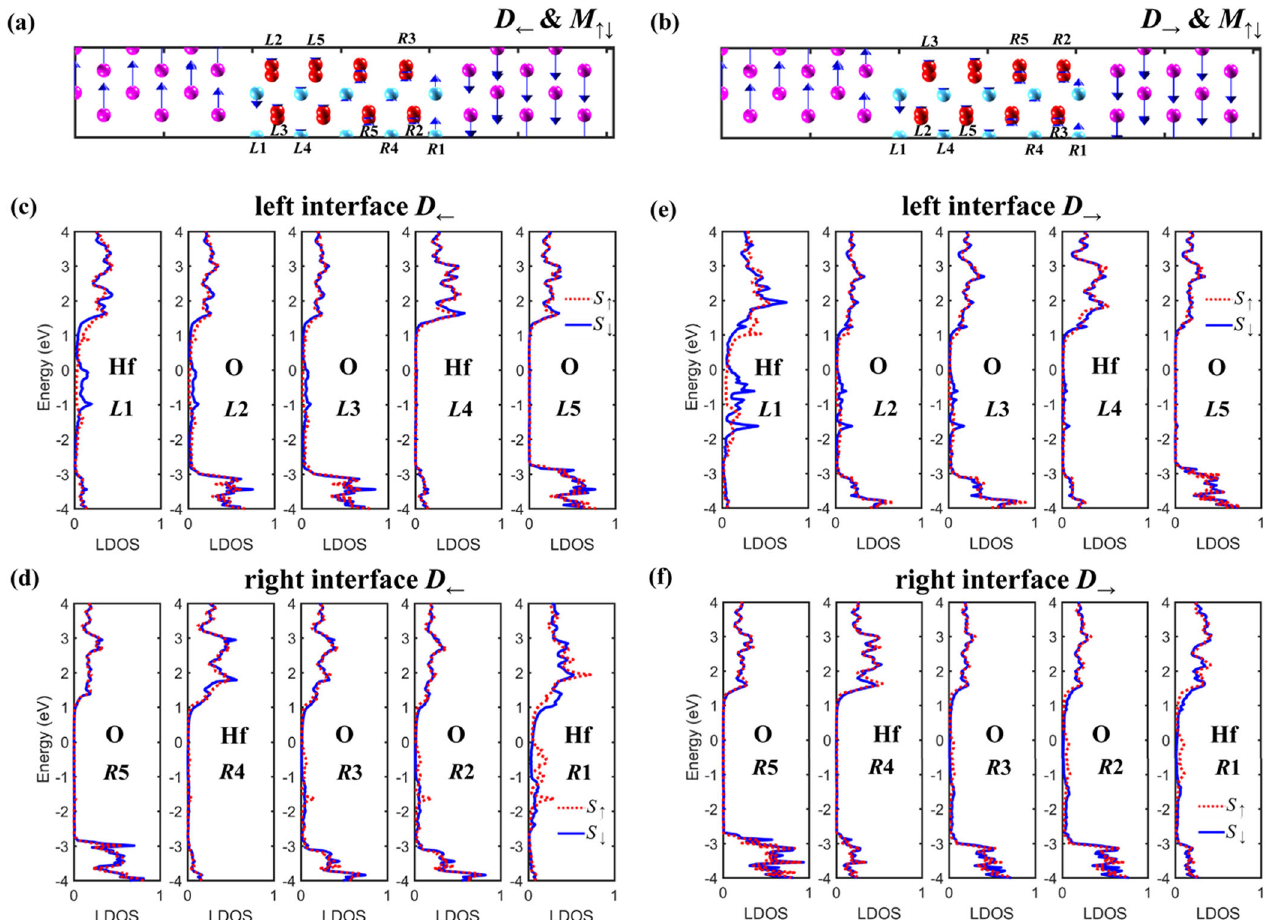
Fig. 4 Local magnetic moments and local density of states of Co/HfO 2 /Co junctions with Hf-terminated interfaces. Local magnetic moments of Co/HfO 2 /Co junctions with Hf-terminated interfaces at an antiparallel state: ( a ) D ← and ( b ) D → . The fi ve atomistic layers at the left and right interfaces are indicated. Layer dependent spin density of states of fi ve atomistic layers at left and right interfaces of Co/HfO 2 /Co junctions with Hf-terminated interfaces: ( c ) the left interface and ( d ) the right interface at D ← , ( e ) the left interface and ( f ) the right interface at D →